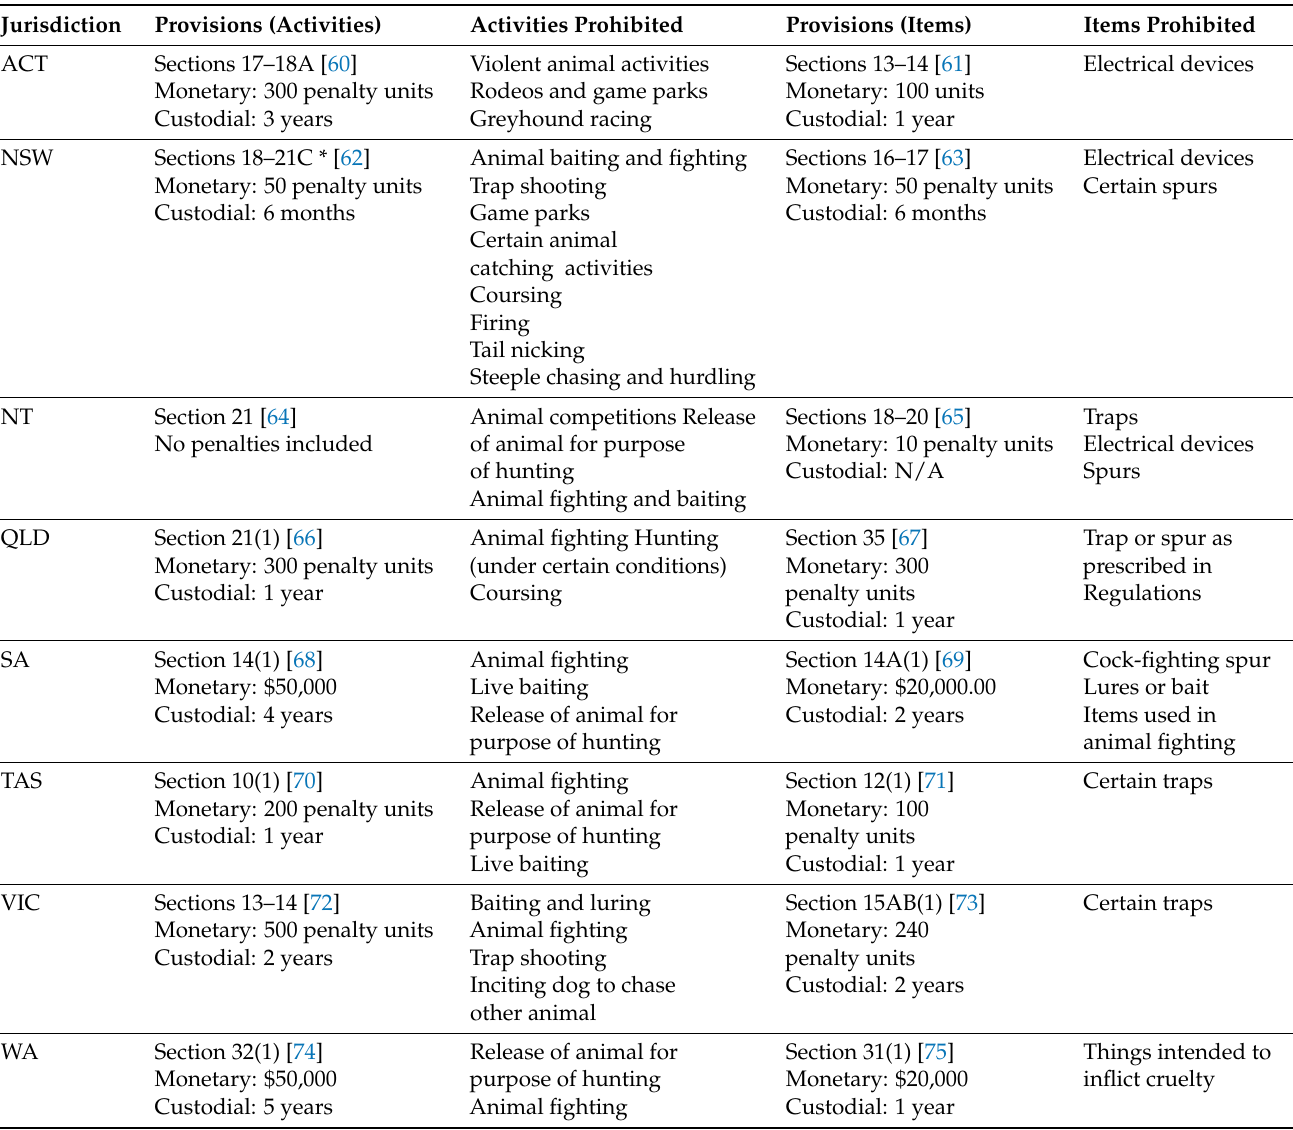
Table 6. Each offence pertaining to participating in prohibited activities and using prohibited items on animals, and the corresponding maximum penalties per each state and territory’s animal welfare act. Penalties are applicable to natural persons; separate penalties apply for body corporates. Note: In a number of jurisdictions, there is referral to associated regulations for specific conditions, which are not listed